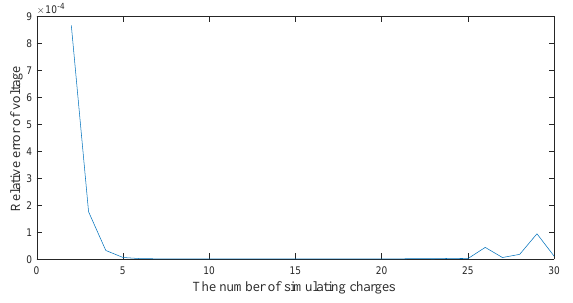
Figure 11. The relationship between number of simulating charges and relative error of voltage.